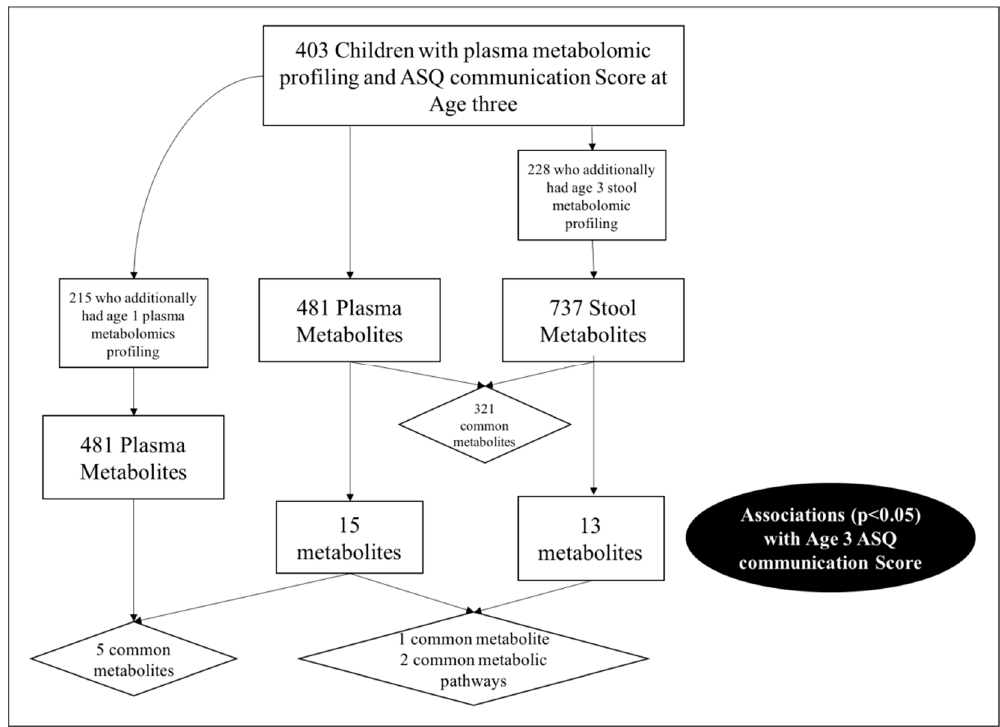
Figure 1. Study schematic and cross-over in communication score associated metabolites.